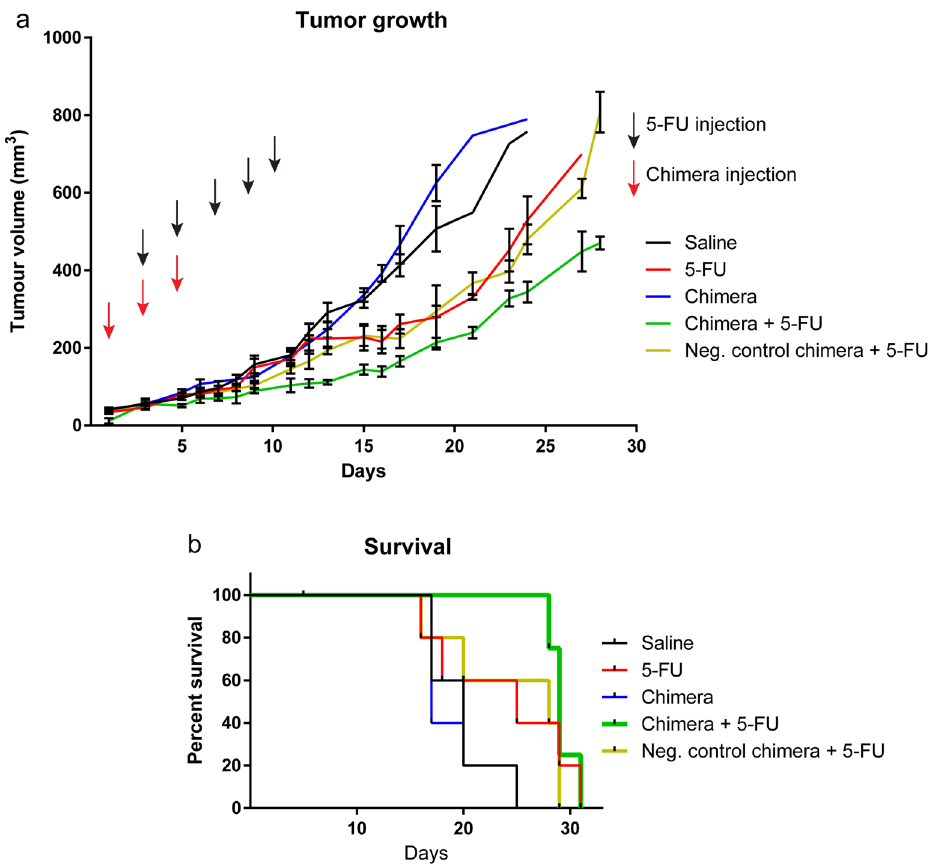
Figure 3. Combined chimera and 5-FU treatments improves therapeutic outcome in HT-29 tumour-bearing mice. ( a ) The graph represents the tumour volume in mice in response to various treatments as indicated. ( b ) Survival rate of mice observed over the course of various treatments. Data shown are mean ± SEM, n =